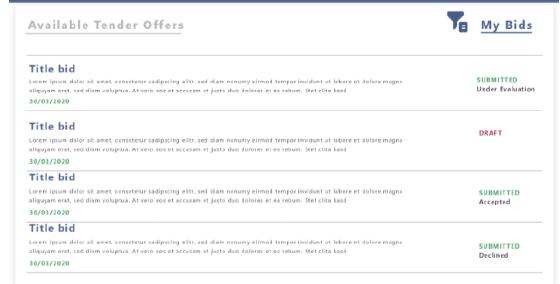
Figure A5. List of bids for a specific